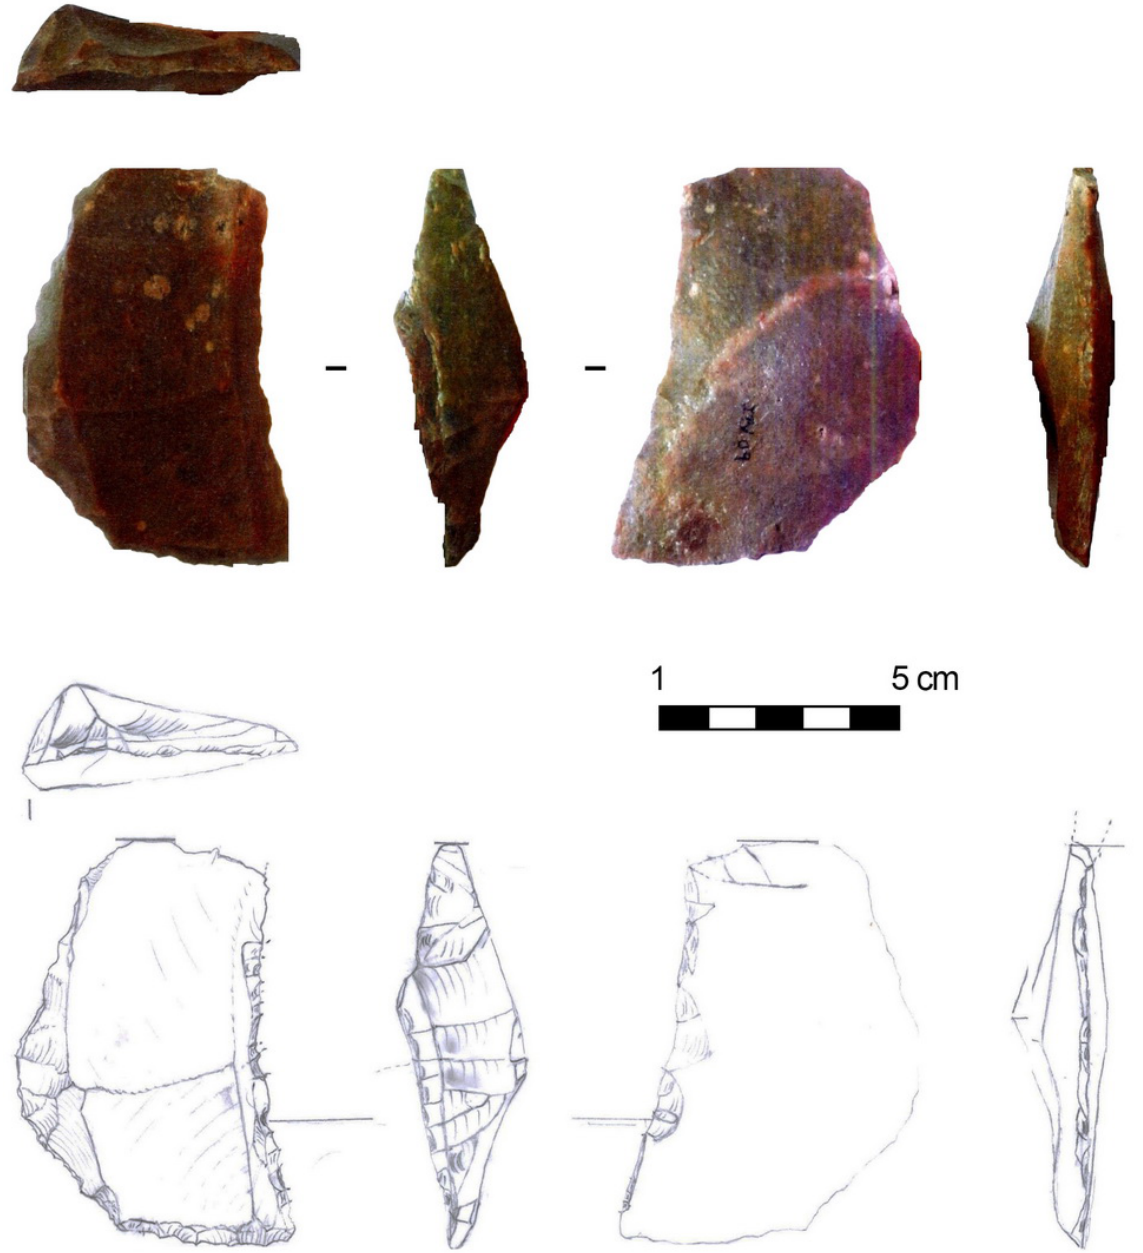
Figura 3: Artefato lítico retocado, sítio arqueológico Abrigo de Itapeva. Foto e desenho: Tatiane Souza (2017). Figure 3. Reotuched lithics artifact from the Abrigo de Itapeva archaeological site. Photo and drawing: Tatiane Souza